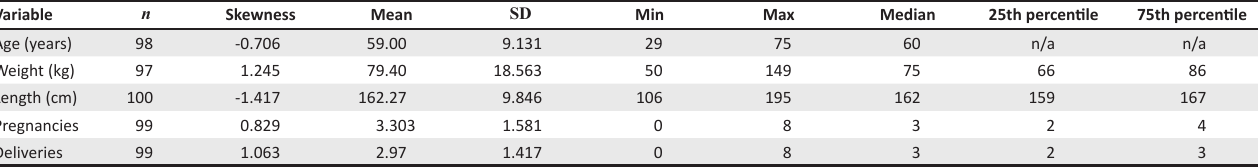
TABLE 1: Results for demographic variables (continuous). Variable